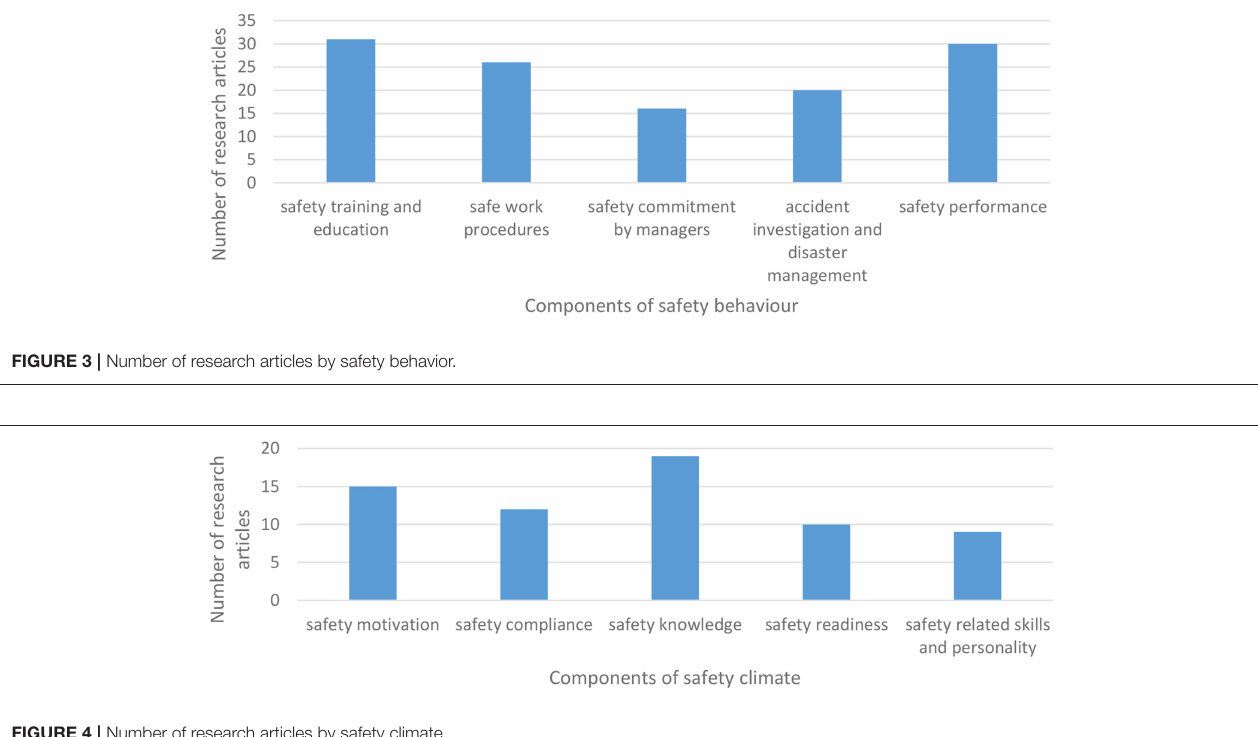
FIGURE 4 | Number of research articles by safety climate.